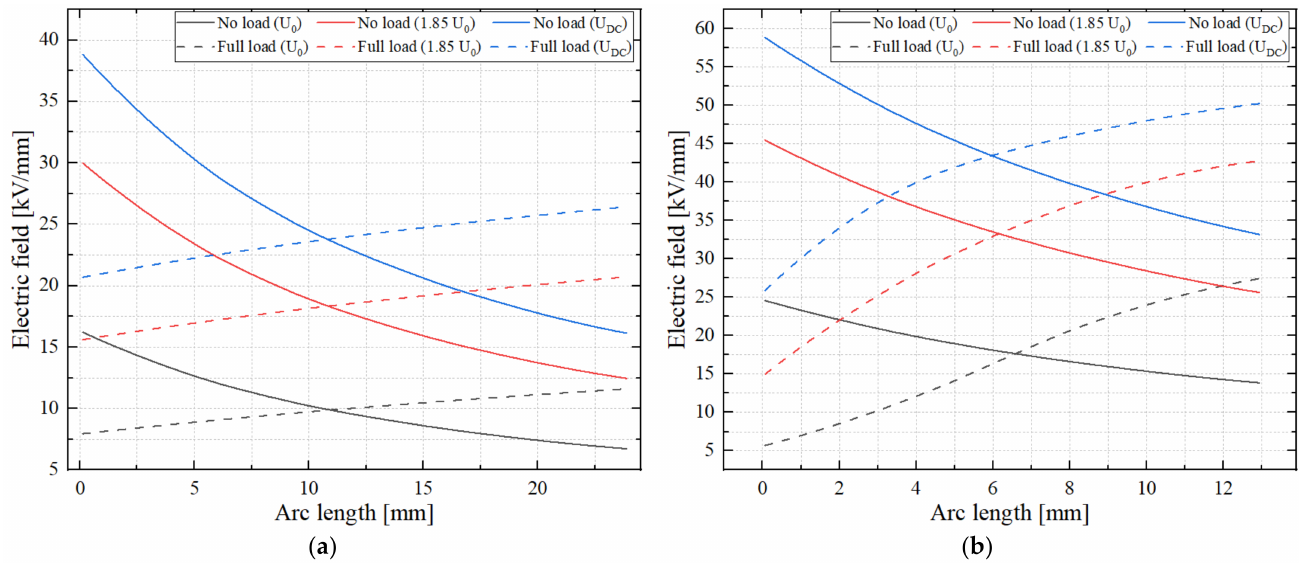
Figure 6. Electric field profile of the cable insulation under various voltage conditions ( a ) XLPE cable; ( b ) PP